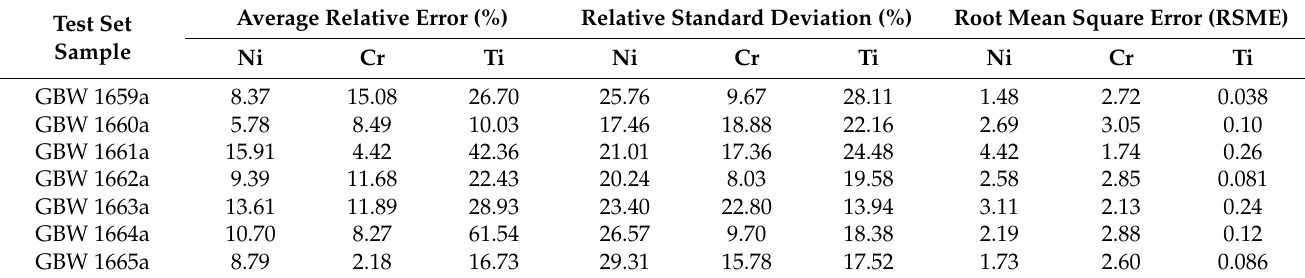
Table 6. Determination result without pre-processing (Group 2).